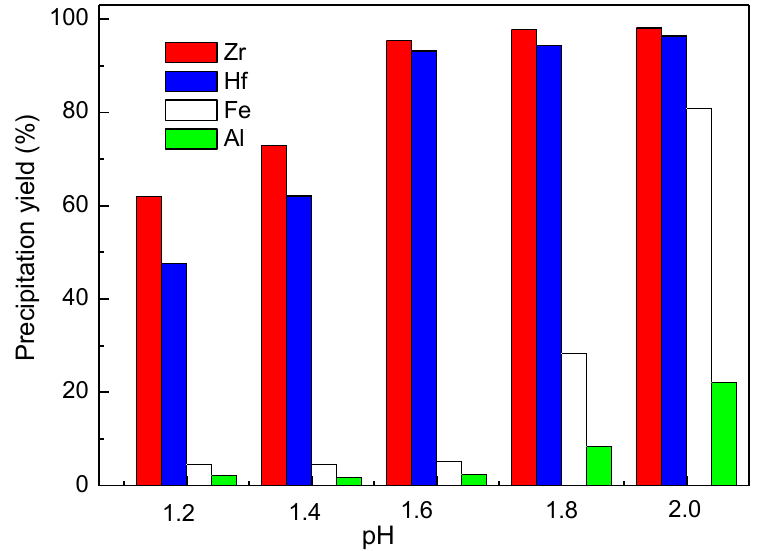
Figure 7. Effect of pH on the Zr precipitation yield, Zr precipitation conditions: 75 °C, C(SO 42‒ ) = 12.4 g/L, 60 min.